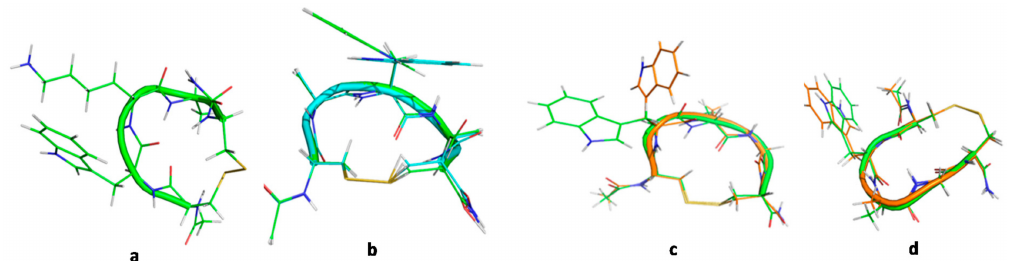
Figure 5. Representative models (geometry optimized middle structures) of the studied peptides obtained from clustering of the MD ensembles. ( a ): Ac-c(CWKAC)-NH 2 in H 2 O, cluster 1 type II β -turn (green tube), d 1 (Trp-SS): 9.82 Å, d 2 (Trp-Lys): 5.20 Å; ( b ): Ac-c(CAWAC)-NH 2 in H 2 O, clusters 1 and 2, type IV β -turn (green and blue tubes), d 1 (Trp-SS): 9.44 and 8.83 Å, respectively; ( c ): Ac-c(CWAGC)-NH 2 in DMSO, clusters 1 and 4, type IV β -turn (green and orange tubes), d 1 (Trp-SS): 9.1 and 8.6 Å, respectively; ( d ): Ac-c(CWAGC)-NH 2 in DMSO, clusters 3 and 5, type II β -turn (green and orange tubes), d 1 (Trp-SS): 10.25 and 10.19 Å, respectively.